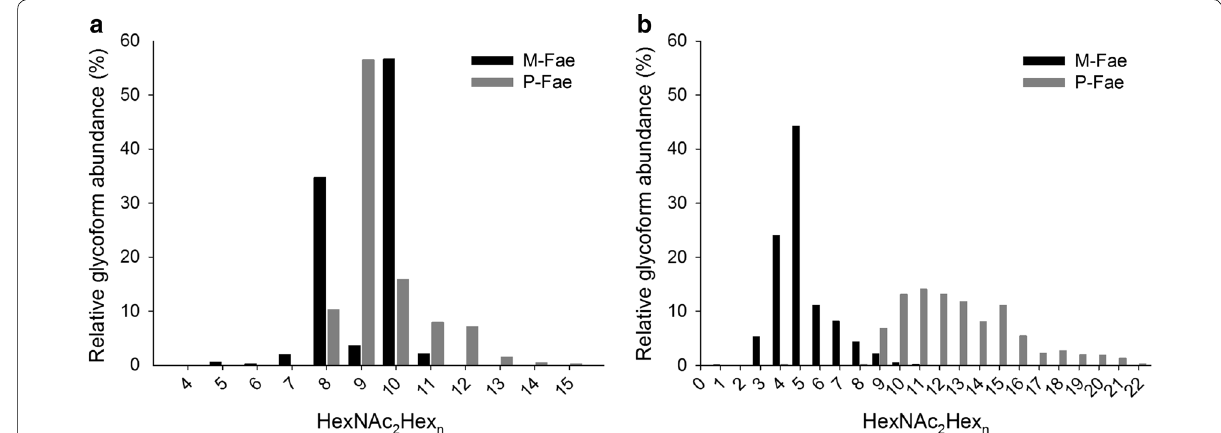
Fig. 3 Relative glycoform abundance at the two glycosylation sites of M‑Fae and P‑Fae. a Asn 179 glycosylation site. b Asn117 glycosylation site. X‑axis: glycoforms, HexNAc 2 Hex n , where “n” is the number on the axis. Hex: